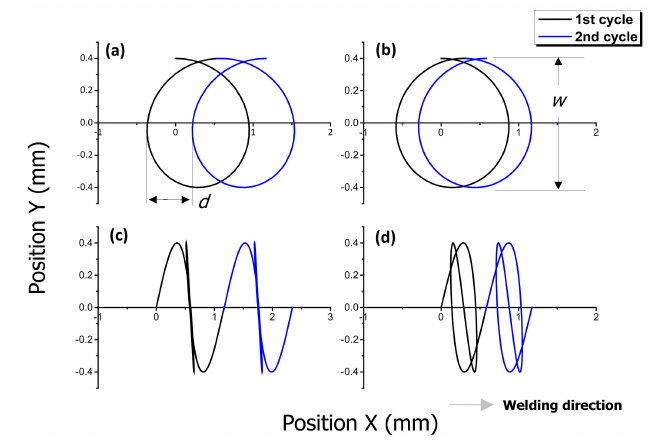
Figure 1. ( a ) Experimental setup for oscillating laser beam welding; ( b ) Schematic image of the self-restraint test specimen [8] to evaluate hot cracking susceptibility.